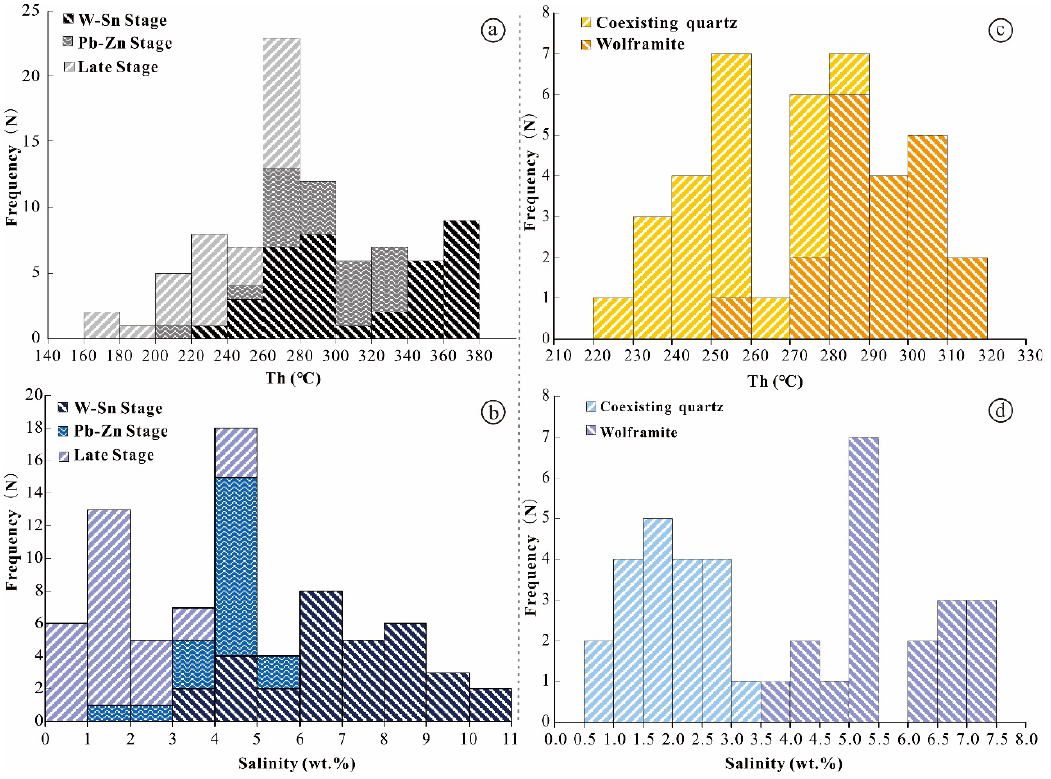
Figure 8. ( a , b ) Histogram of homogenization temperature and salinity at each mineralization stage. S1-S2 stage analysis minerals: quartz; S3 stage analysis minerals: quartz, fluorite, calcite; ( c , d ) histo- gram of homogenization temperature and salinity of wolframite and its coexisting quartz.